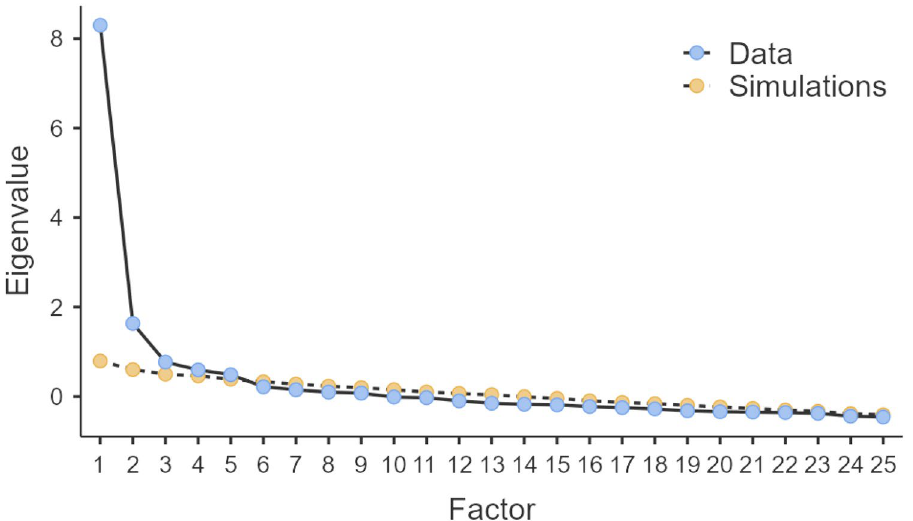
Figure 1. Scree plot with reference eigenvalues based on parallel analysis